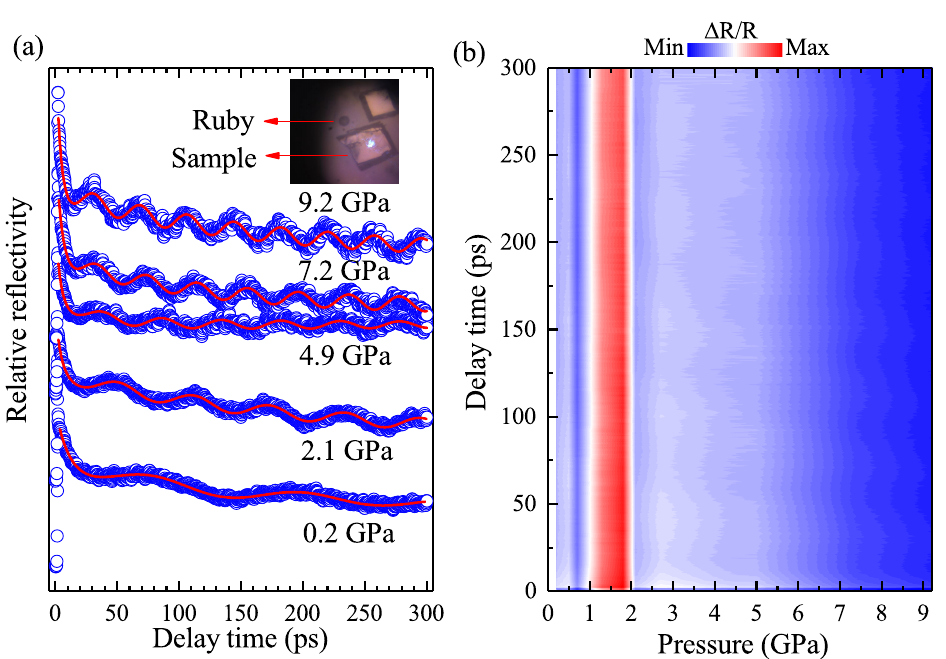
Figure 2. Pressure-dependent femtosecond spectroscopy of FeTe 0.5 Se 0.5 from the pressure range of 0.2 to 9.2 GPa. ( a ) Normalized time-resolved differential reflectivity The inset figure on the top shows the loaded ruby and two pieces of shiny samples. The blue open circles denote the experimental data measured at different pressures. The red solid lines represent the fitting curves. ( b ) Mapping of the pressure-dependent femtosecond spectroscopy. The spectrum ∆ R is presented by different colors placed at the top of the intensity of the R